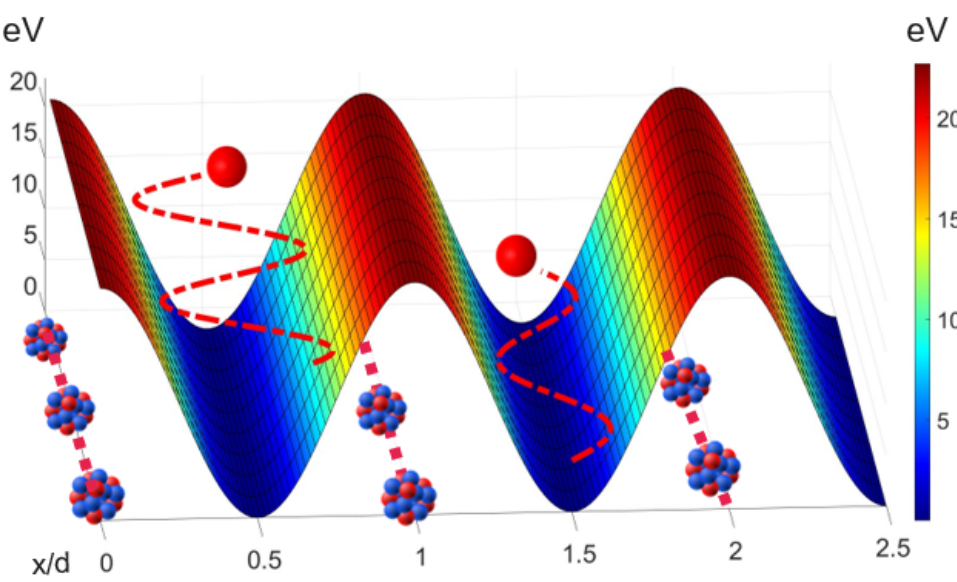
Figure 1. Sketch of atomic planes continuous potential and channeling for positive particles, the horizontal axis unit x / d indicate the direction x perpendicular to the lattice planes, normalized by the distance d between two adjacent atomic plane. The y axis indicate the direction parallel to the lattice plane. The potential shows maxima along the nuclei on the atomic planes, letting positively charged particles oscillate between two adjacent planes while crossing the